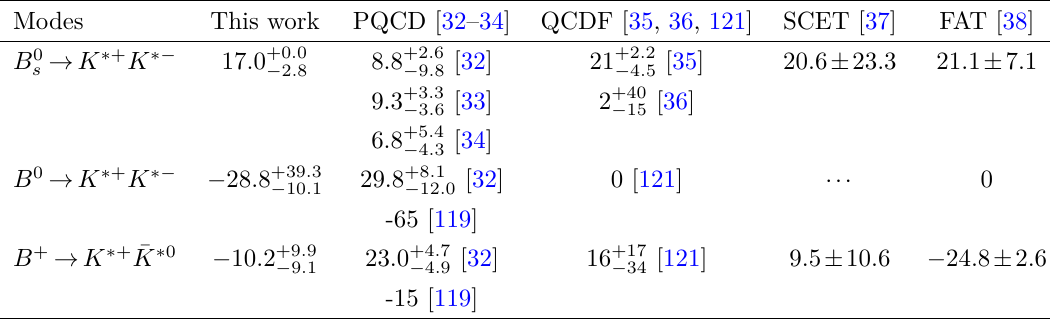
Table 6 . Direct CP asymmetries ( % ) in the B → V V decays compared with previous analyses.